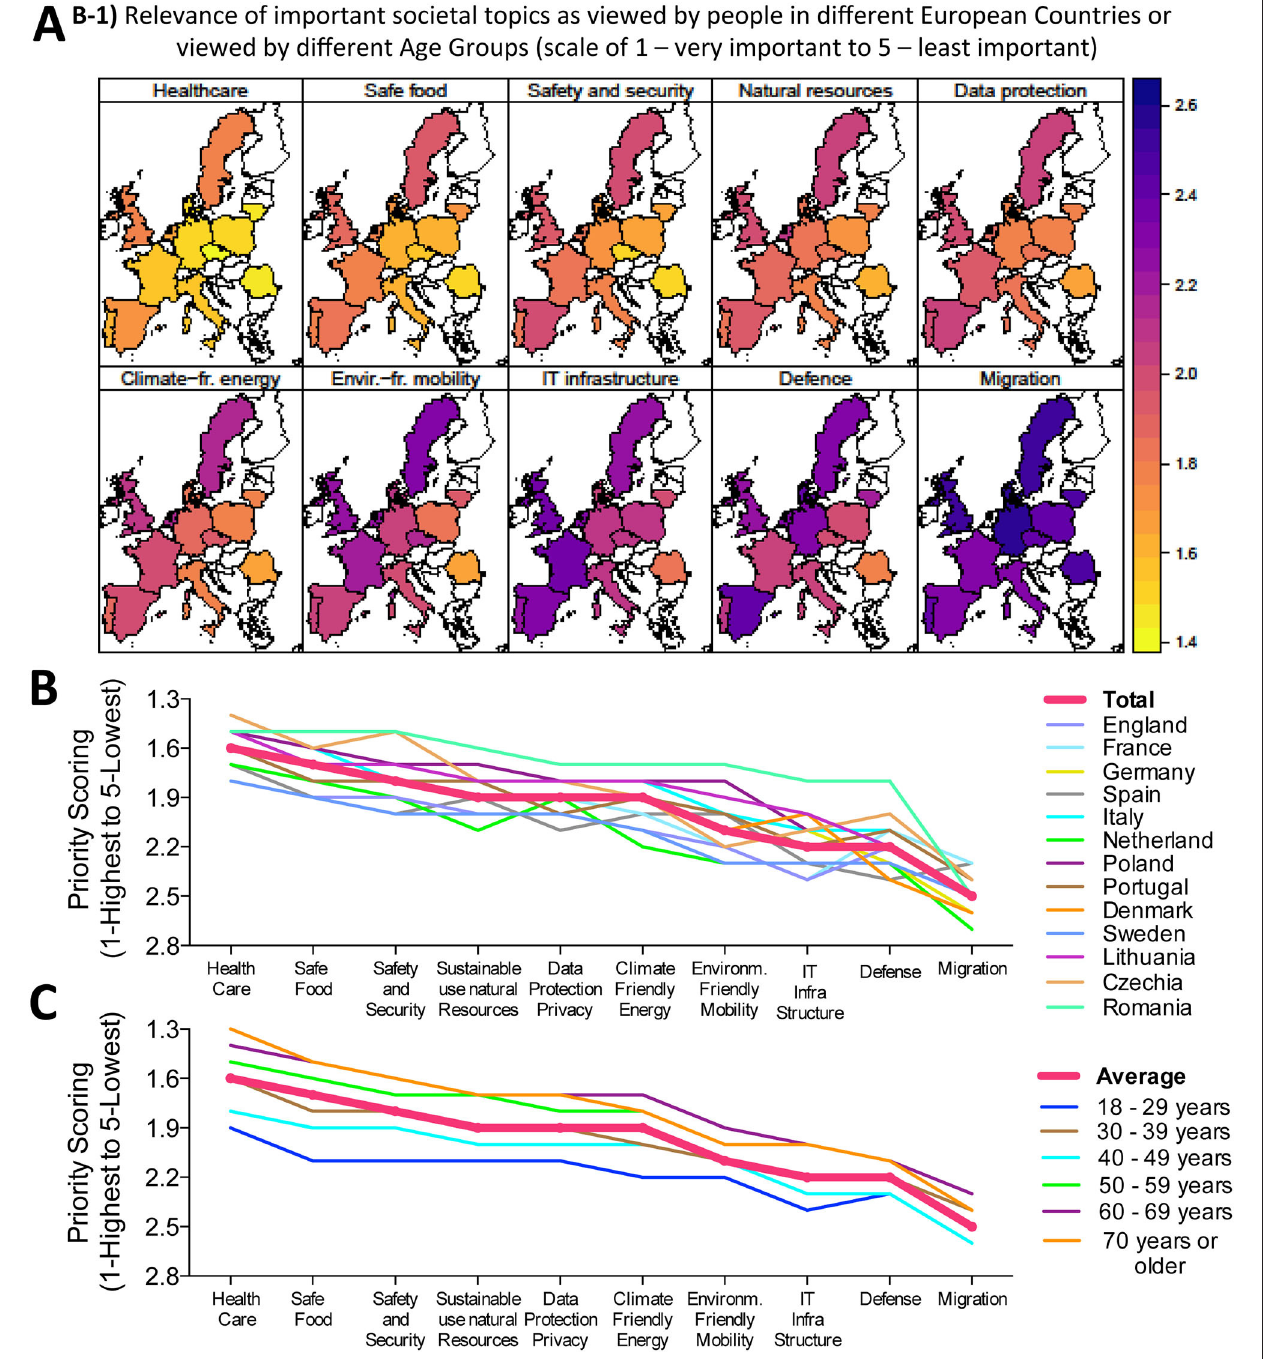
FIGURE 1 | General assessment of important social topics. Relevance of important societal topics as viewed by people in different European countries or viewed by different age groups (Scale 1—very important to 5—least important), (A) Geographical heat map representation of the ten studied topics, with impact scale bar shown to the right and top ranking issue ‘Healthcare’ depicted in yellow-orange color tones, while the lowest ranking issue ‘Migration’ is depicted in purple-blue color tones. (B,C) Numerical depiction of priority scoring sorted according to issue and country (shown in B ) or according to issue and population age (shown in C ).